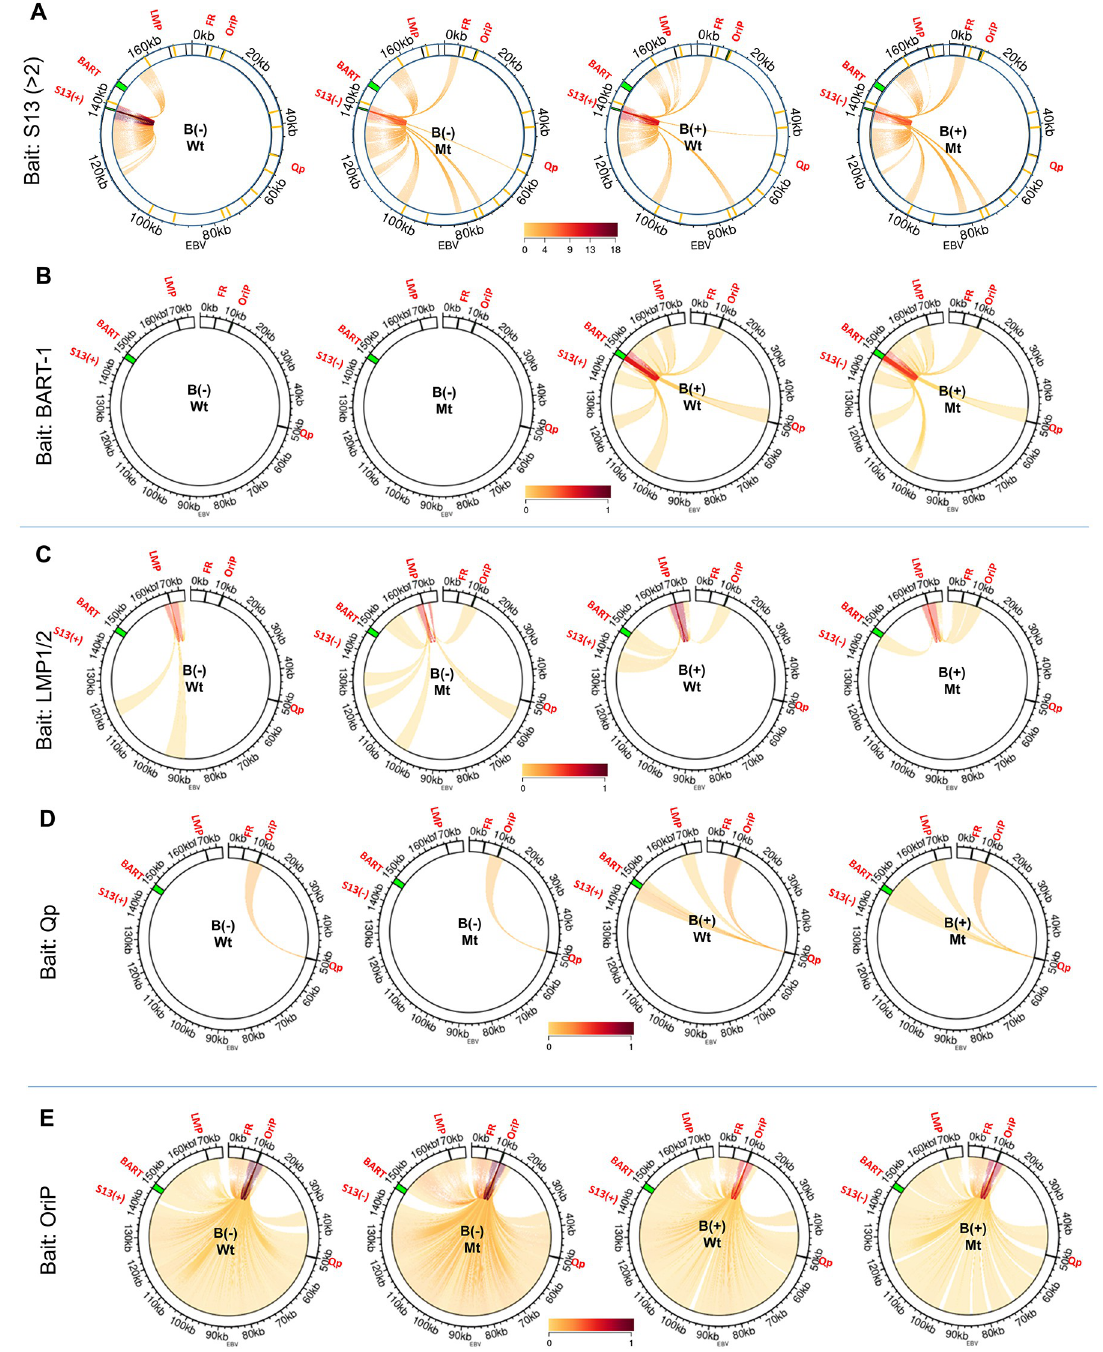
Fig 9. Confirmation of chromatin interaction affected by BARTp CTCF BS mutation. Significant genomic associations of target viewpoint regions in HEK293-EBV genomes identified by 4C-Seq assays. A) To compare EBV genomic associations with the S13 locus, we adjusted the 4C-seq read numbers from S13 viewpoint primer set to 3,000 in the 4C-seq analysis of Wt BART(+/-) � S13 + and Mt BART(+/-) � S13 - cells (S5 Table). B-E) To compare EBV genomic associations with other loci such as BART-1, BART-2, LMP1/2, Qp, OriP, and FR, total read numbers from all target viewpoints were adjusted to 7,000,000 in each cell (S4 Table). 4C-seq assays revealed all interactions of BART-1 (B) , LMP1/2 (C) , Qp (D) , and OriP (E) regions in Wt BART(+/-) � S13 + and Mt BART(+/-) � S13 - EBV genomes. Locations of viewpoint primer sets were posted in S3 Table; S13 (EBV 138504 ~ 138987), BART-1 (EBV 147357 ~ 147490), LMP1/2 (EBV 166480 ~ 166661), Qp (EBV 50278 ~ 51579), OriP (EBV 9918 ~ 10302) and FR (EBV 4731 ~ 4961).